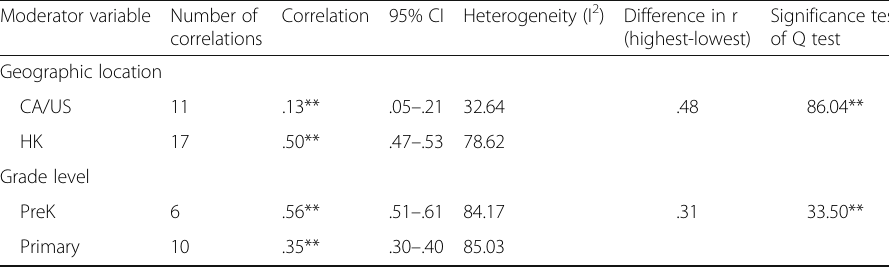
12:1 years and the majority of the studies were conducted in mainland China (38%) followed by Hong Kong (25%) and US (25%). Figure 5 shows that the overall correl- ation is small, r = .37, 95% CI [.31, .42], but significant, z(8) = 12.35, p < .01. The Table 4 Number of correlations, correlation, 95% confidence interval, heterogeneity statistics, difference in r between categories and significance test of categories for moderators of the relationship between Chinese and English